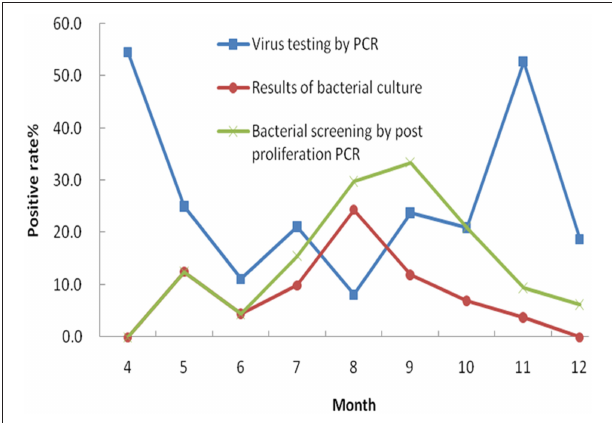
FIGURE 2 | Seasonal epidemic occurrence curve for viruses and